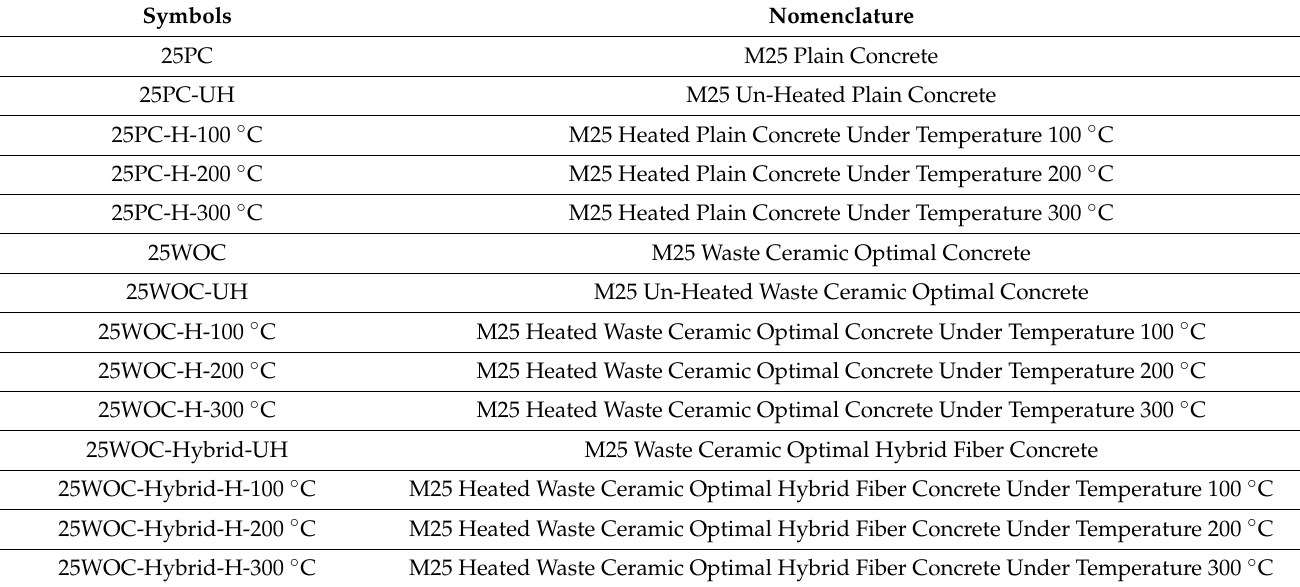
Table 5. The total used symbols in the present